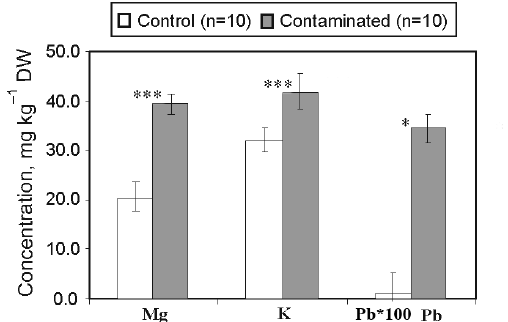
plots: * – p > 0.05 and *** – p < 0.001. Fig. 5. Concentration of Mg, K and Pb in wood on both control and contaminated plots. Values are means ±SD (vertical lines). Value of Pb concentration (control) is multiplied by 100